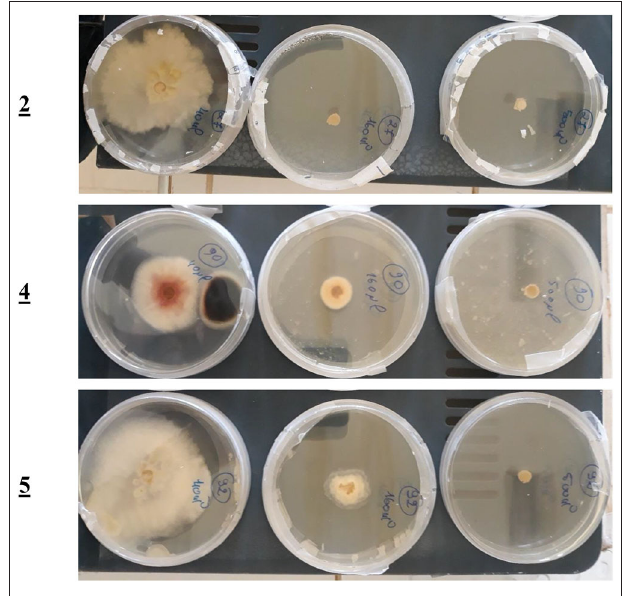
FIGURE 7 | The F.o.a. Petri plates picture for compounds 2 , 4 , and 5 .